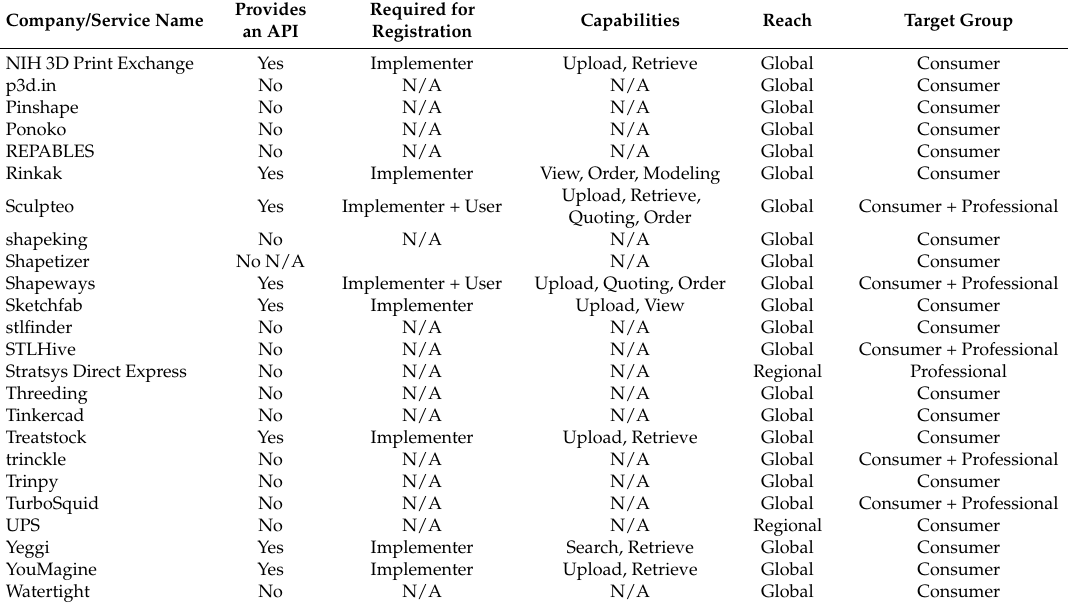
Table 4. 3D printing platforms and services and their APIs—Part